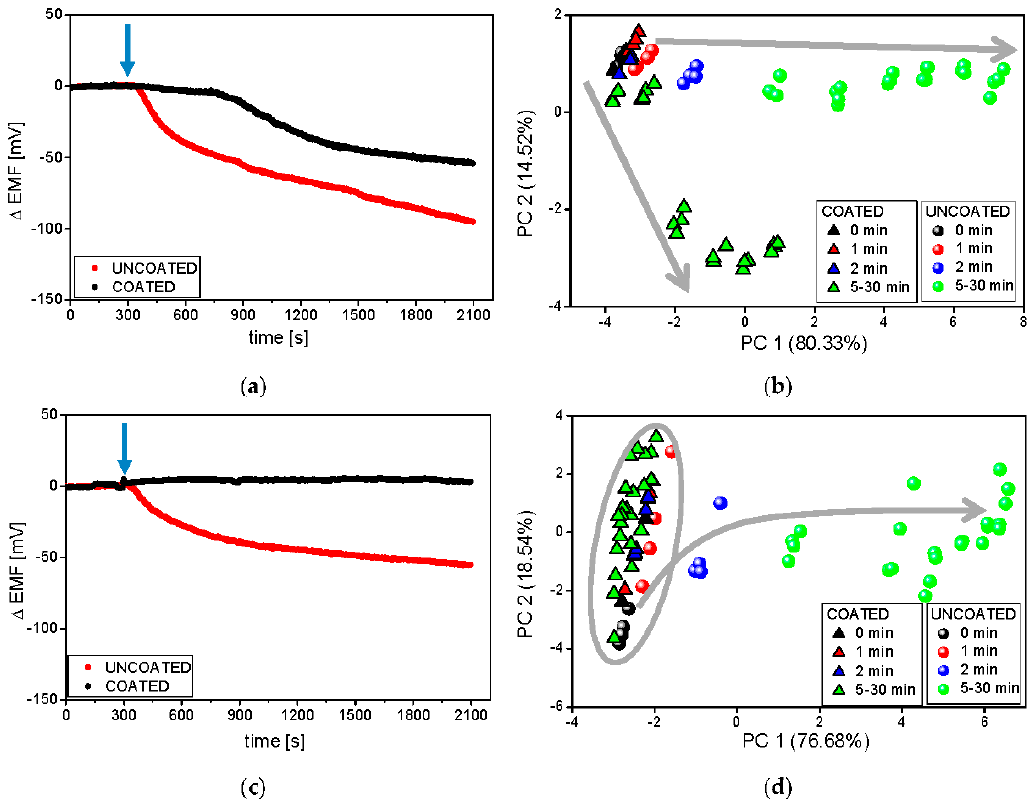
Figure 4. Raw signals of the PS-N electrode and respective PCA plots during the release process from minitablets uncoated and coated with Eudragit E, carried out in phosphate buffer pH 6.9 at 37 °C ( a , b ) and room temperature ( c , d ). The blue arrows represent the moment of the introduction of minitablets into the dissolution medium. Grey arrows represent following time points.